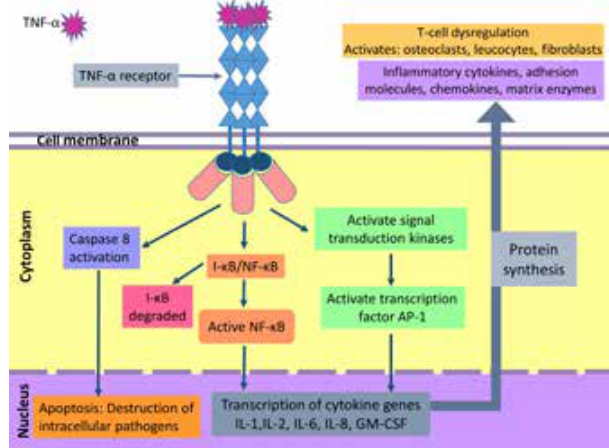
Figure 2. The multiple roles of TNF-α in the immune